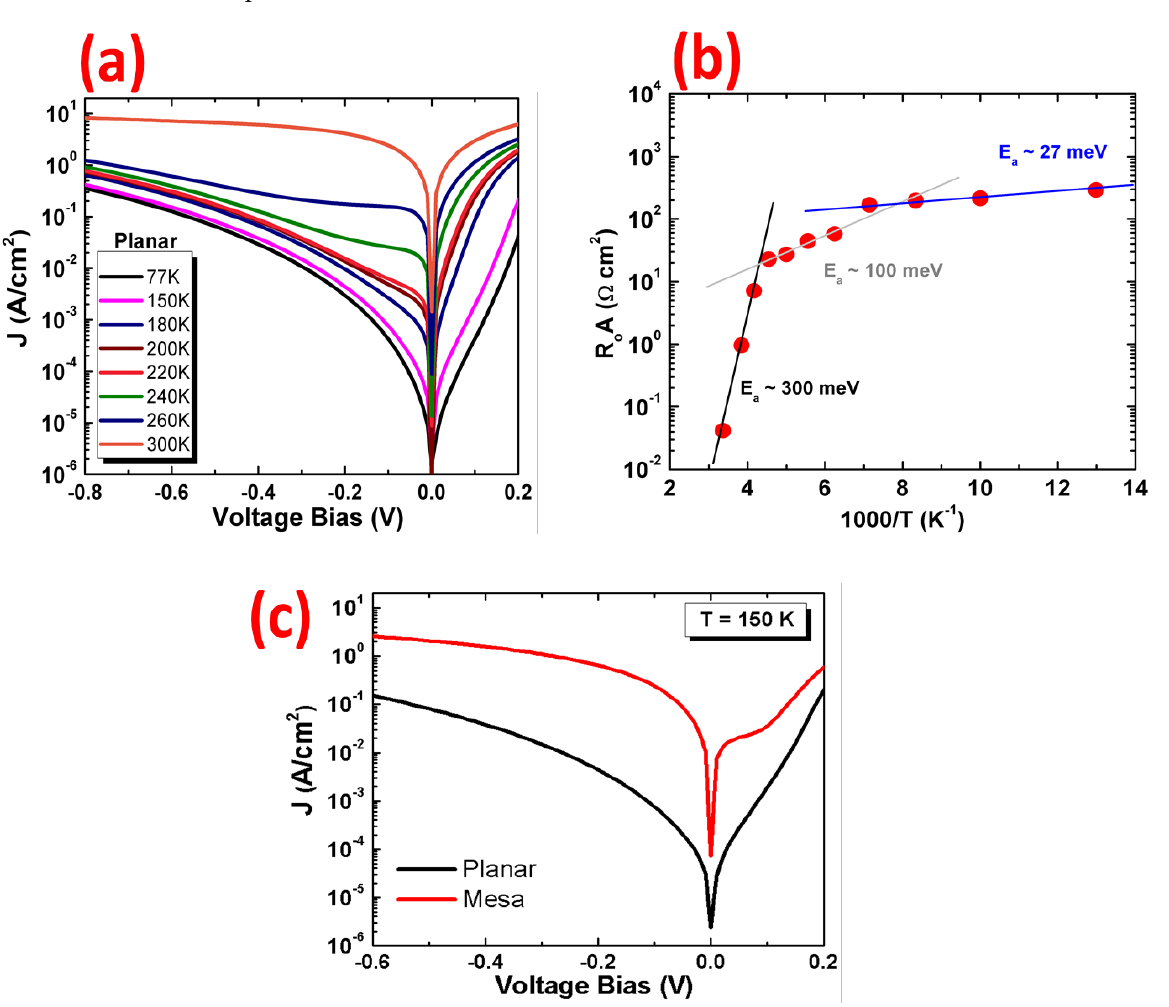
Figure 3. ( a ) Dark current density vs. applied bias voltage characteristics for the MWIR planar photodetector at different temperatures. ( b ) R0A vs. 1/T relation from 77 K to 300 K ( c ) Comparison of the dark current density of the planar and mesa-etched photodetectors at 150 K.